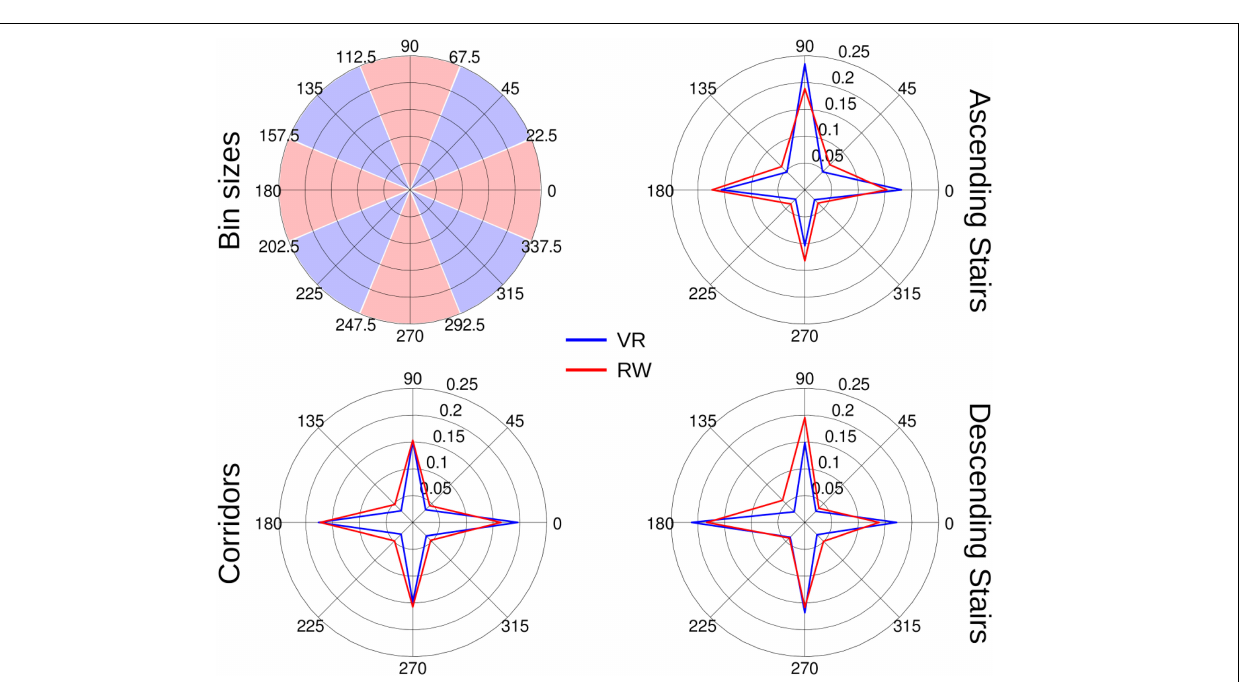
FIGURE 9 | Histograms of eye-movement directions as polar plots. Non-zero differences in gaze position between consecutive samples were accounted by direction of gaze movement in bins of 45 ◦ centered on the cardinal and oblique axes (see top–left panel). Data was normalized per individual to unit integral before averaging across participants. Directions as shown correspond to directions of gaze movements (0 ◦ corresponds to rightward, 90 ◦ to upward gaze movements, etc.).